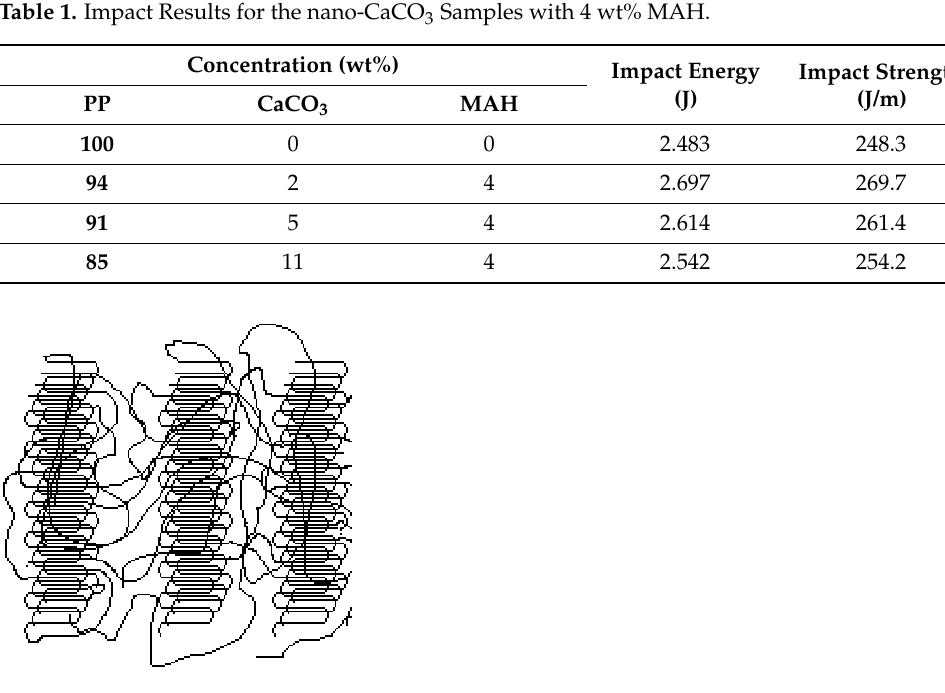
Figure 1. Lamellae crystalline portion with the amorphous portion. Table 1. Impact Results for the nano-CaCO 3 Samples with 4 wt% MAH. Concentration (wt%)